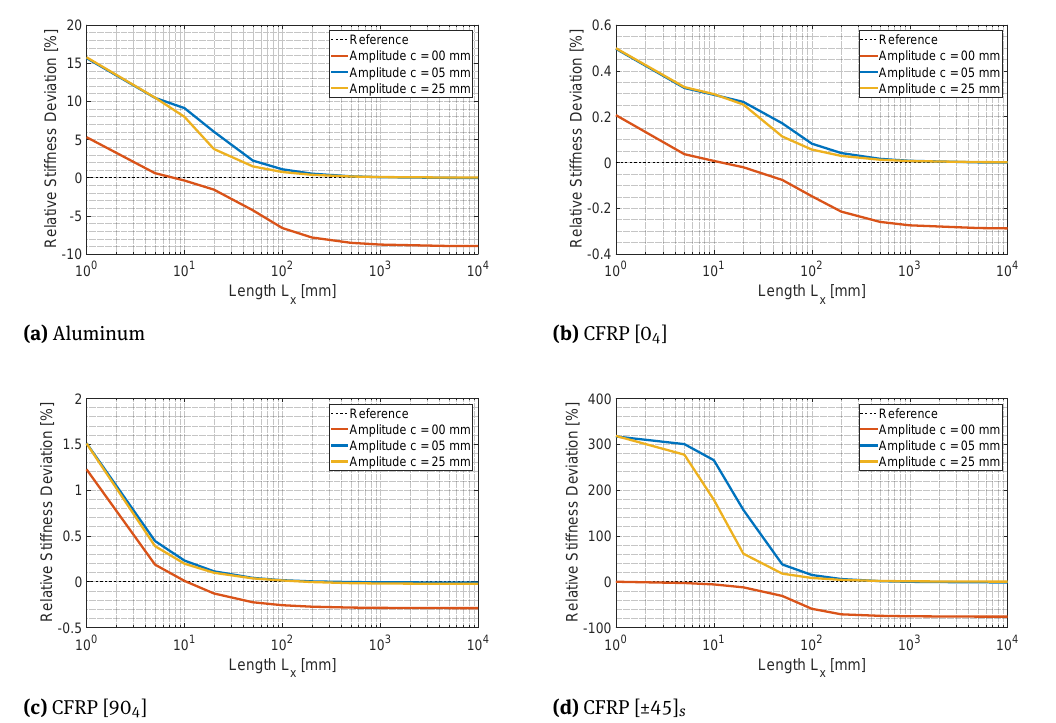
Figure 13: Load case 1 normalized apparent stiffnesses versus L x for constant width P (one unit